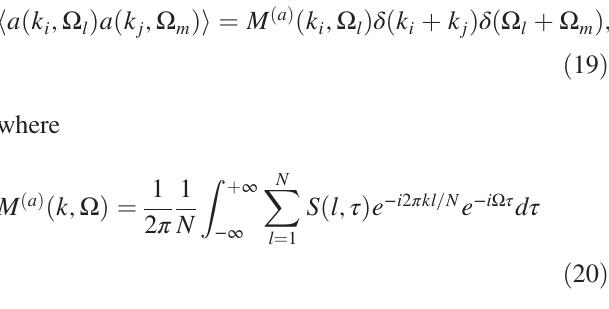
ghost as a function of the tot